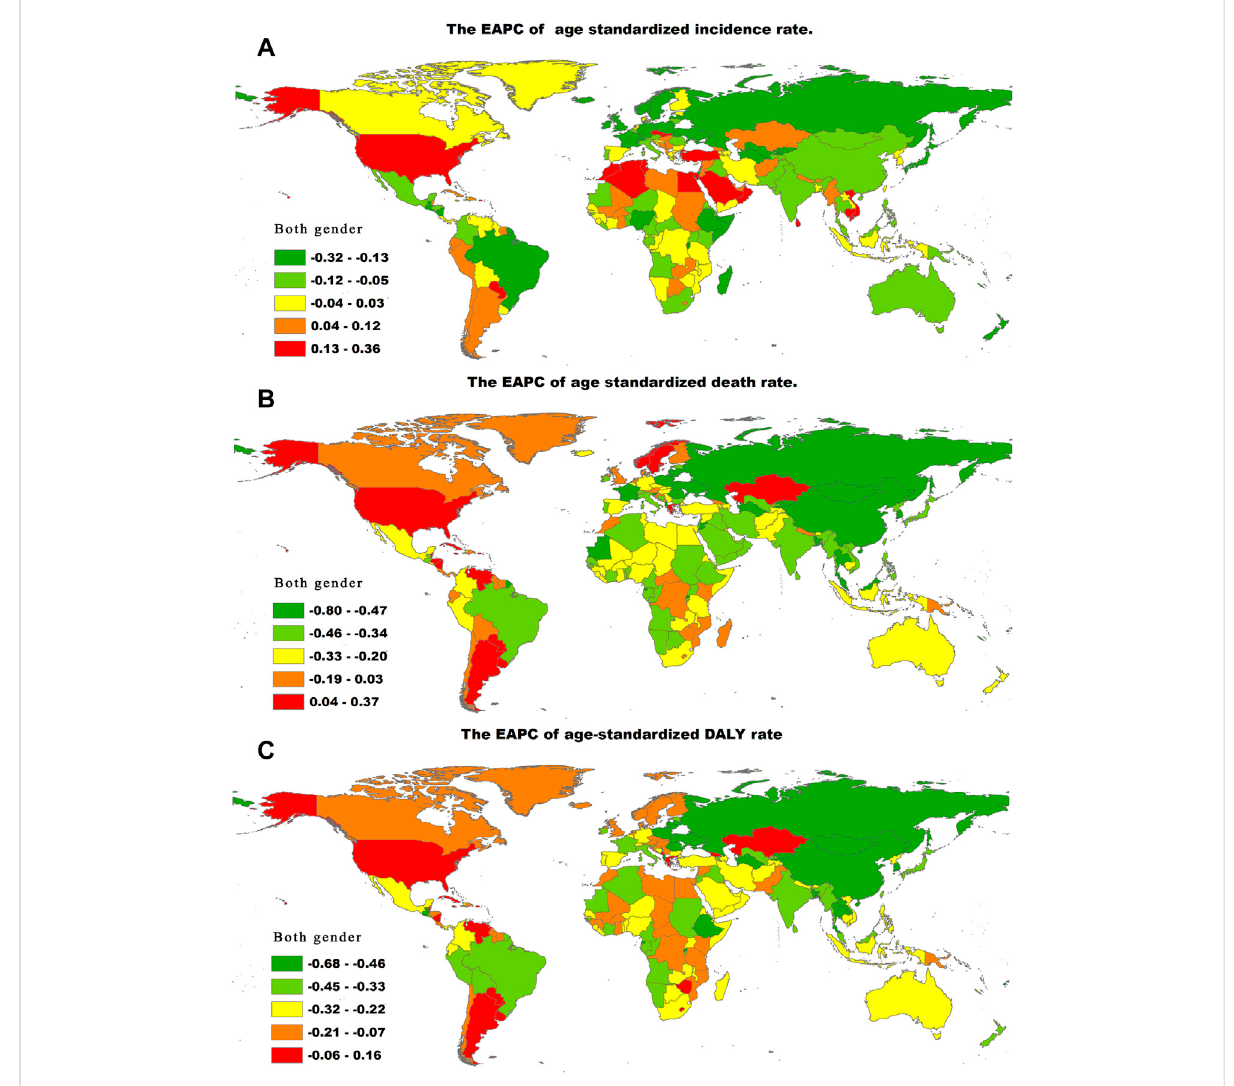
FIGURE 3 TheEAPCofchronicobstructivepulmonarydiseaseage-standardizedratesfrom1990to2019,bycountries. (A) TheEAPCofage-standardized incidence rate. (B) The EAPC of age standardized death rate. (C) The EAPC of age-standardized DALY rate. EAPC = estimated annual percentage change. DALY = disability adjusted